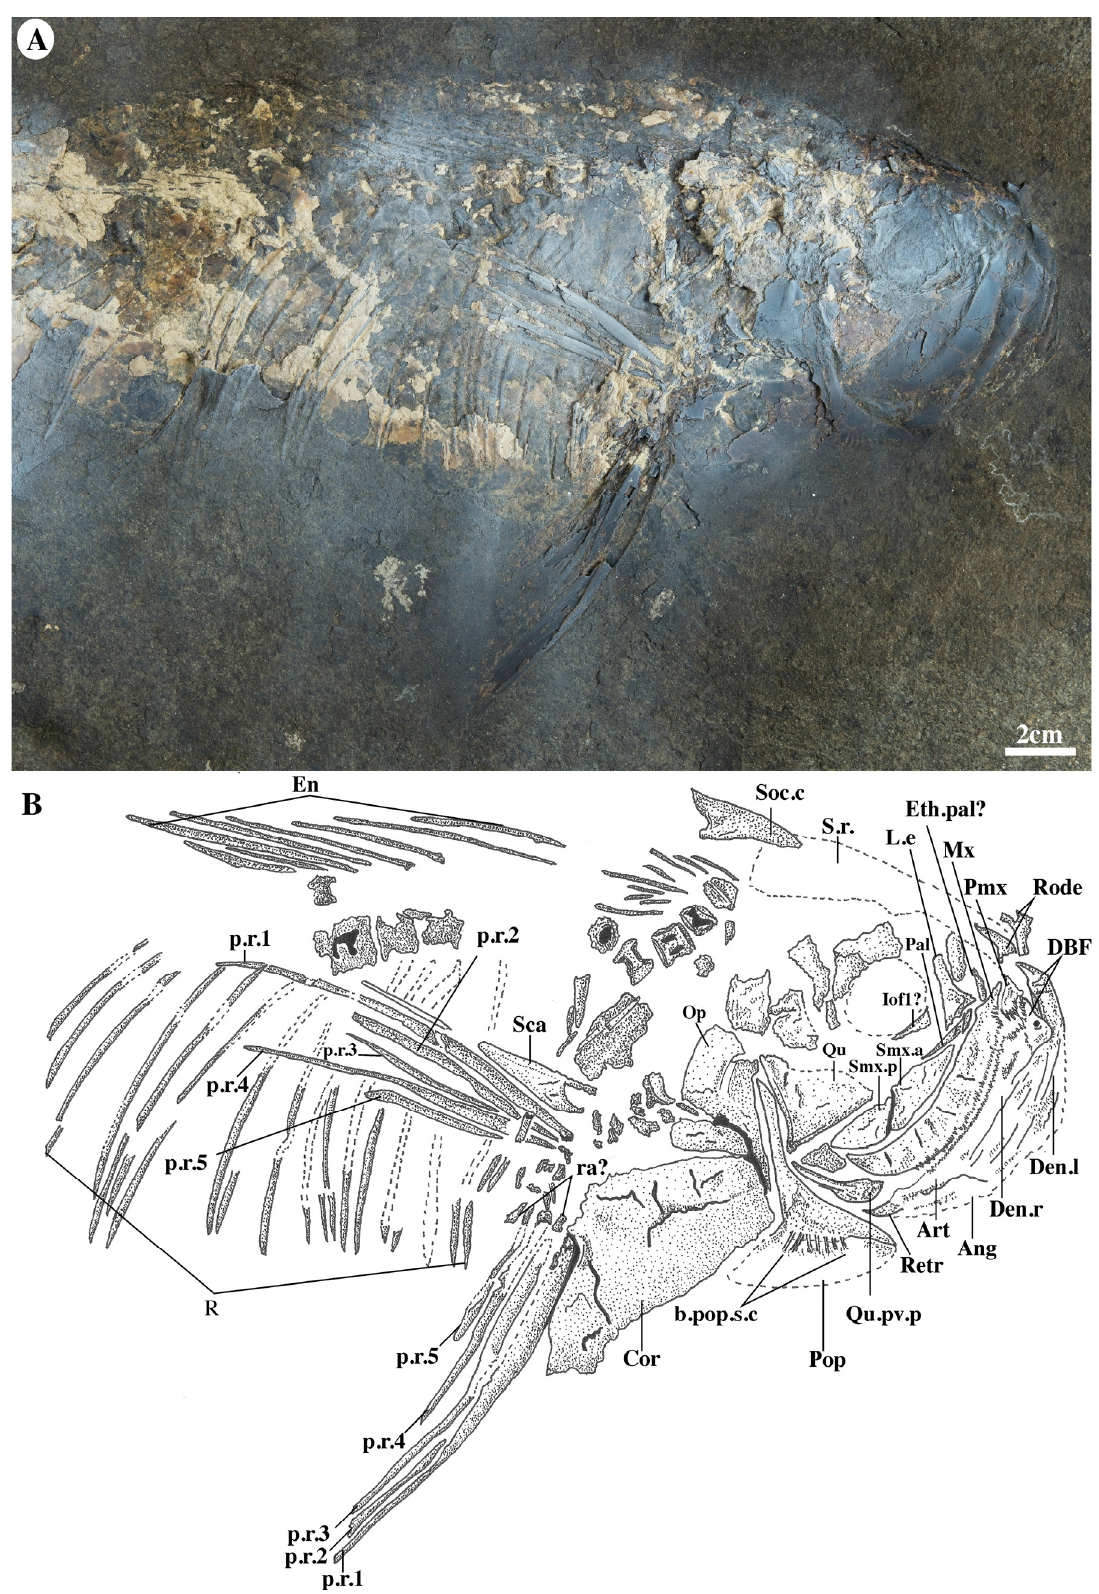
Figure 5. † Cladocynodon araripensis gen. et sp. nov. ( A ) Photo and ( B ) interpretative draw of the holotype CFUFMT 139.